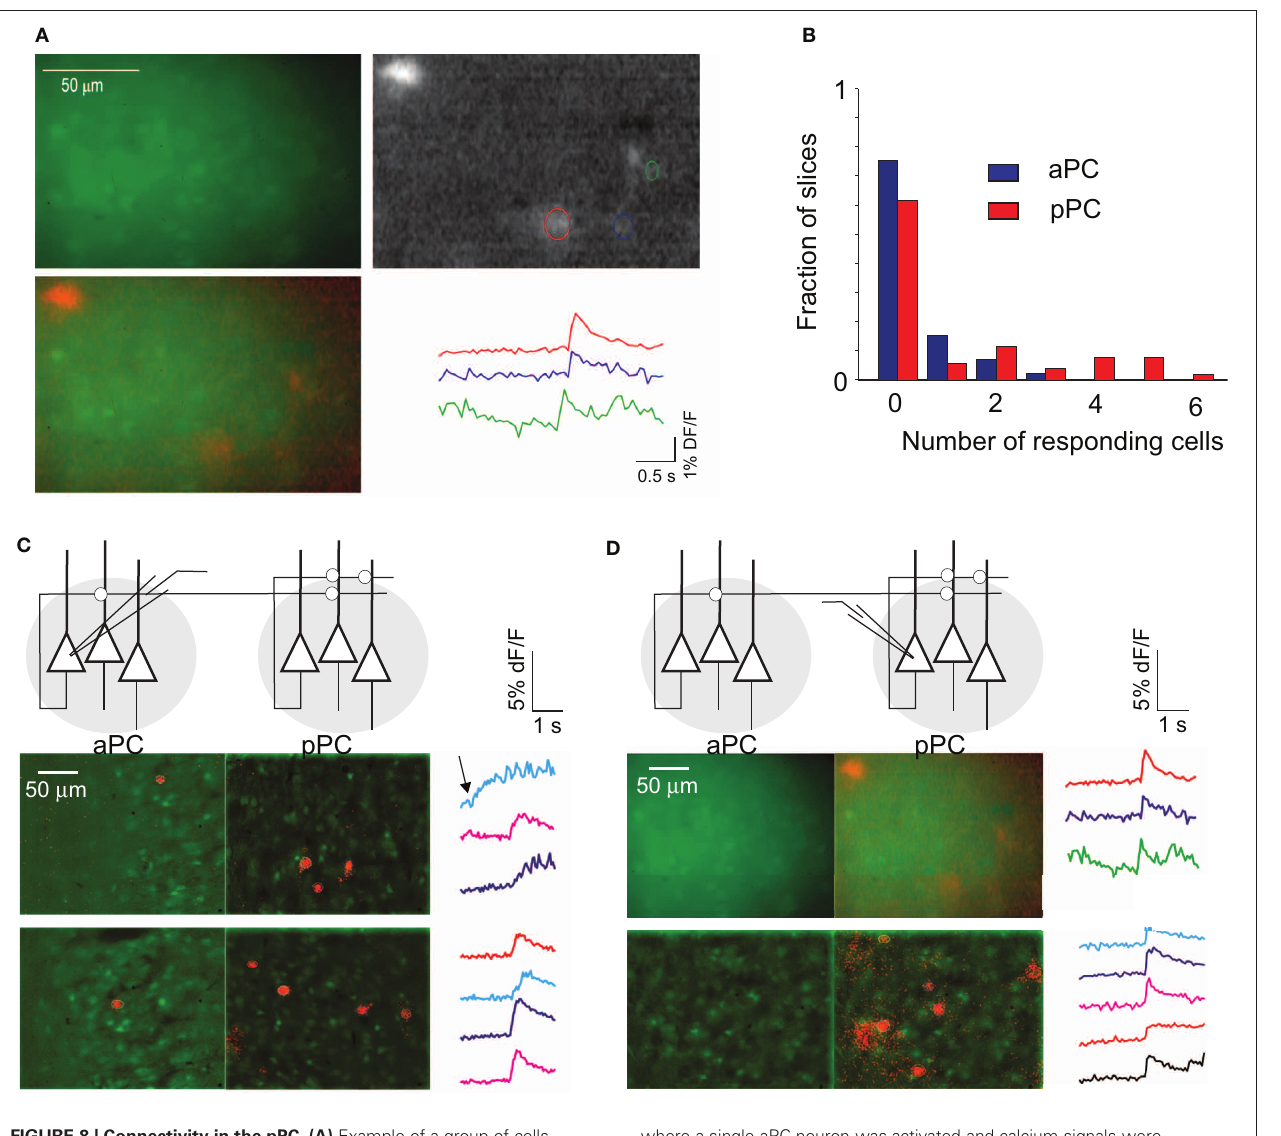
where a single aPC neuron was activated and calcium signals were recorded in the aPC and pPC (on different trials). Two example images are shown, with responding cells shown in red superimposed on resting fluorescence images (green). At right are traces of the responding cells from the pPC. Note that activation of a single aPC cell in these two experiments causes just 1 cell to respond in aPC, but two or more in pPC. One pPC “response” (blue trace) in top panels was rejected based on the fact that fluorescence rise preceded stimulation (arrow). (D) Similar experiments with activation of a single pPC neuron triggered no responses in the